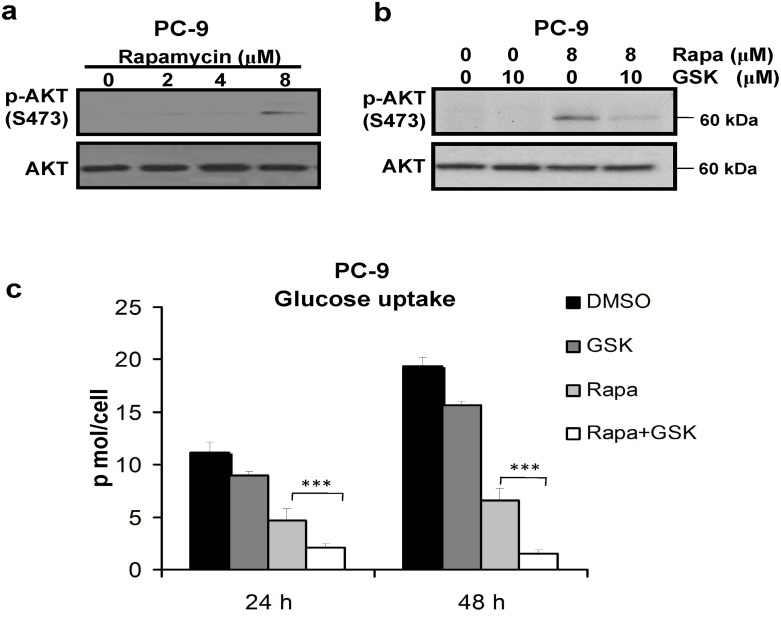
Inhibition of glycolysis metabolism by rapamycin was enhanced by AKT inhibition in PC-9 cells.(a) PC-9 cells were treated with rapamycin for 24 h, and then cell lysates were assayed for p-AKT by Western blotting. (b) PC-9 cells were treated with rapamycin for 24 h and GSK690693 for 1 h respectively, or pre-treated with 10 μM GSK690693 for 1 h and then with rapamycin for 24 h. The cells were probed for p-AKT. (c) Glucose uptake was assayed in PC-9 cells treated with GSK690693, rapamycin, or in the combination. The experiments were repeated for at least three times. Data represent mean ± SD, ***P < 0.001.